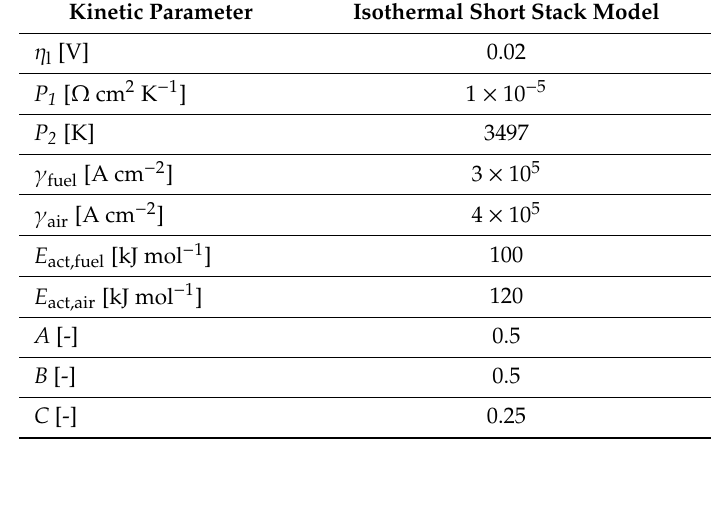
Table 3. Kinetics parameters for the rSOC short stack operating in isothermal conditions.